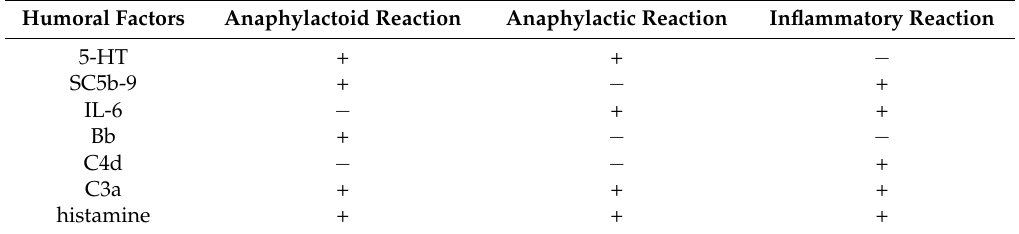
Table 2. Changes of SC5b-9, 5-HT, Bb, C4d, histamine, C3a and IL-6 in anaphylactoid, anaphylactic and inflammatory reactions.